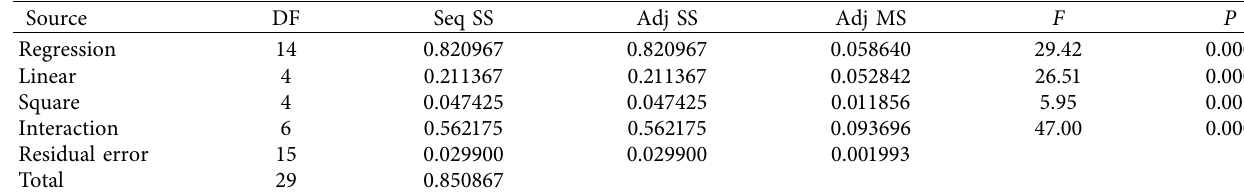
Table 5: ANOVA—delamination for multifaceted